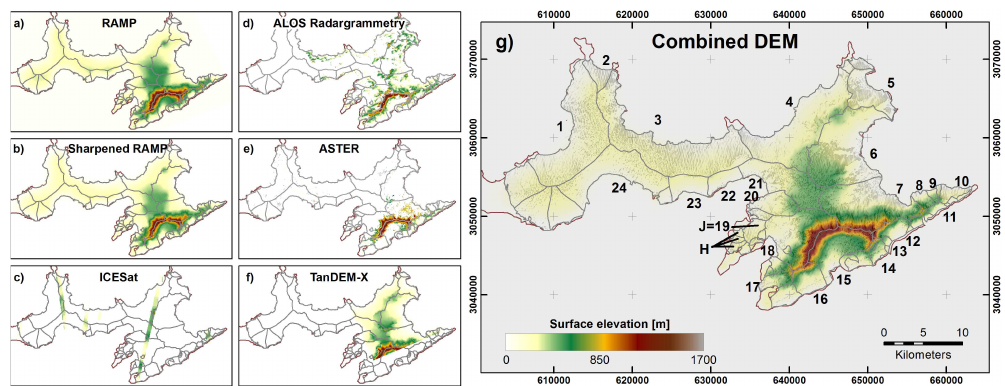
Figure 3. Digital elevation data used in this analysis. There are 792 ICESat data points distributed among five different satellite tracks. Radargrammetry and ASTER data provide elevations outside the TanDEM-X coverage. Hurd Glacier and Johnsons Glacier, where surface mass-balance observations are available, are labelled as H and J, respectively. The brown line indicates the coastline of the ice-free